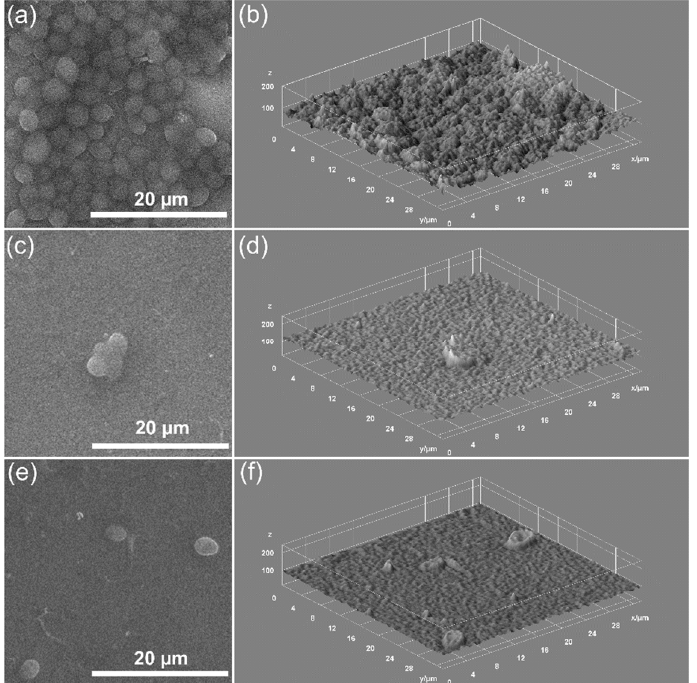
Figure 13. 2D SEM images and 3D representation of SEM images of Candida albicans ATCC 10231 cell development on HAp ( a , b ), 0.05 AgHAp ( c , d ), and 0.1 AgHAp ( e , f ) coatings after 48 h of incubation.